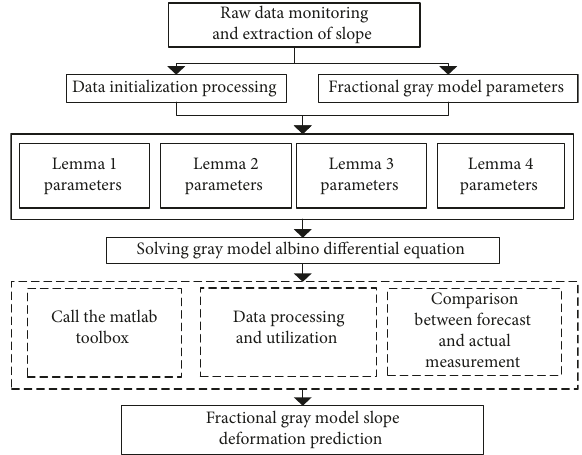
Figure 1: Fractional-order calculus gray model implementation